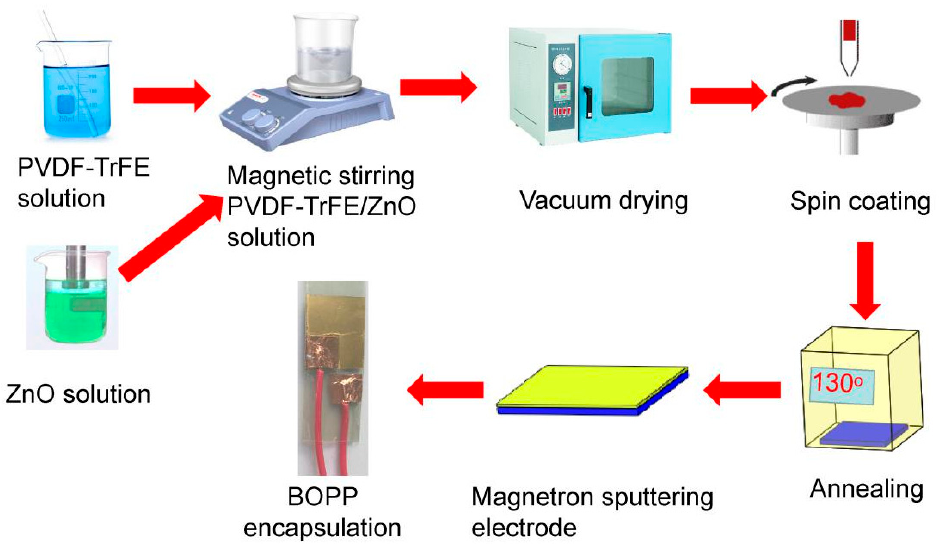
Figure 1. Flow chart of PVDF-TrFE/nano-ZnO piezoelectric film preparation.